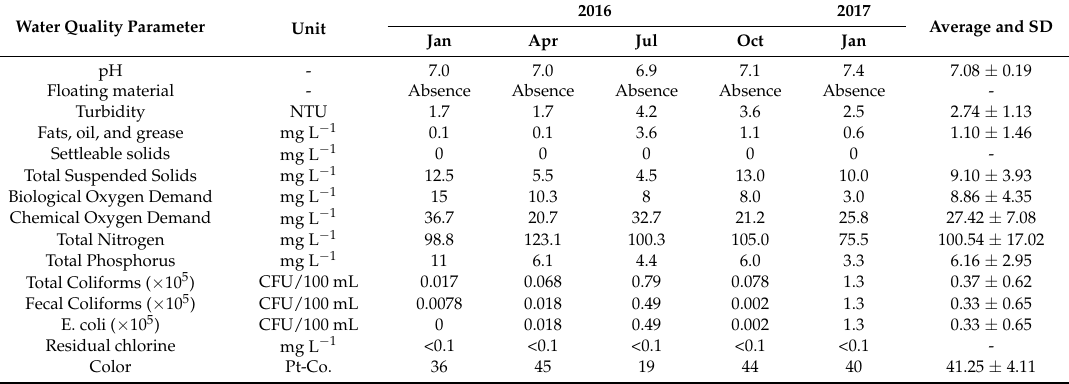
Table 6. Overall efficiency of the system in the pollutants removal and compliance with the regulations.